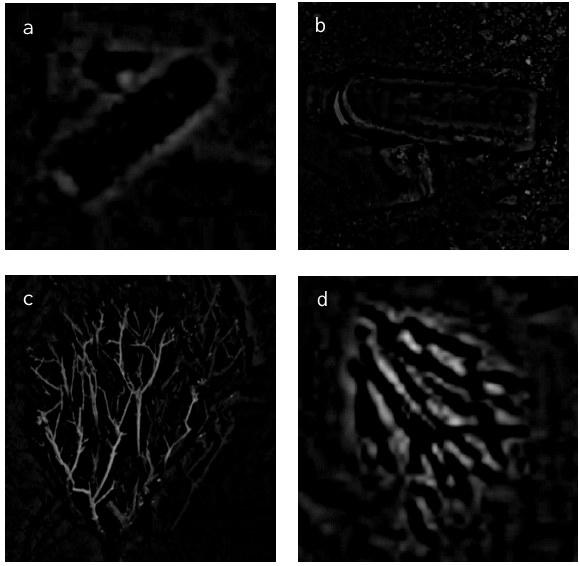
Figure 6. Different views of the same features